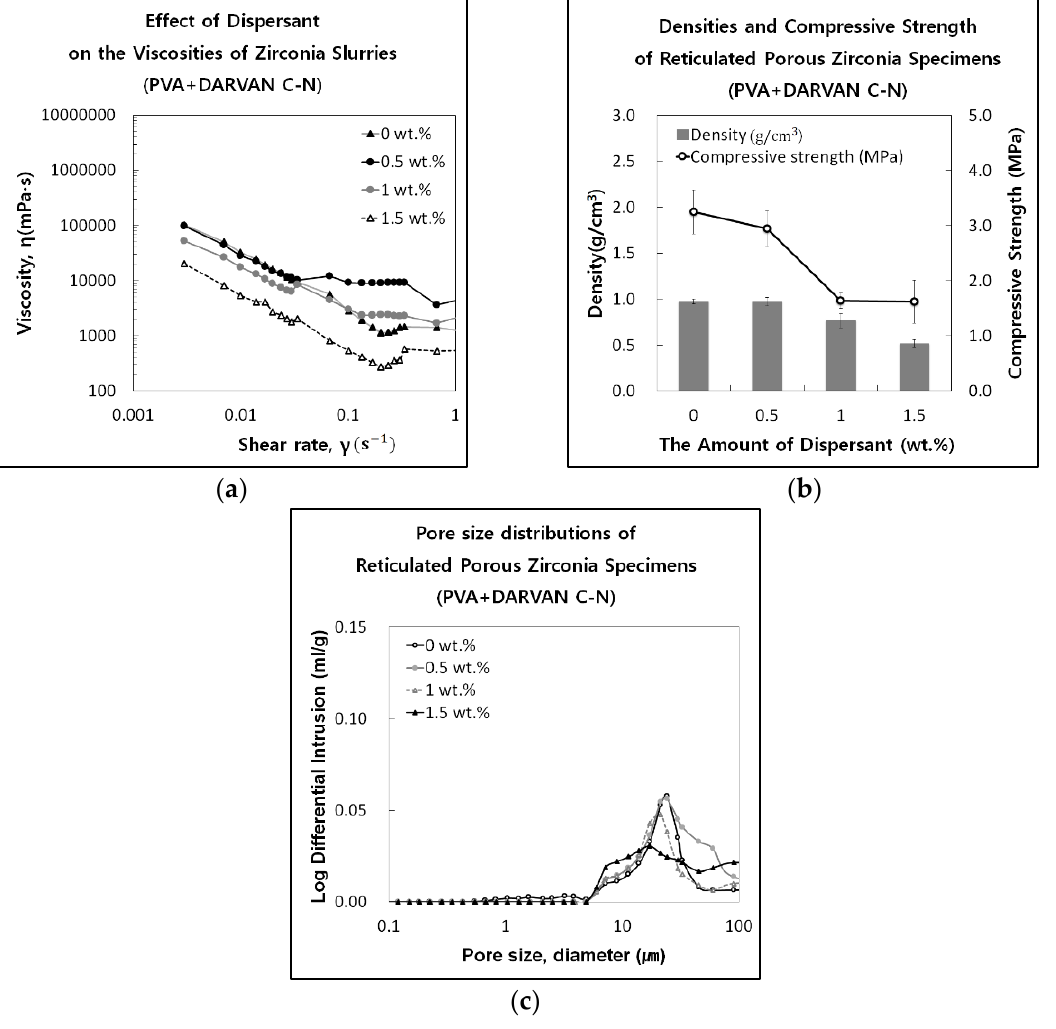
Figure 7. Effects of the addition of a dispersant (0 – 1.5 wt.% DARVAN C-N) on the ( a ) viscosities, ( b ) densities and compressive strength outcomes, and the ( c ) pore size distributions of reticulated porous zirconia specimens.